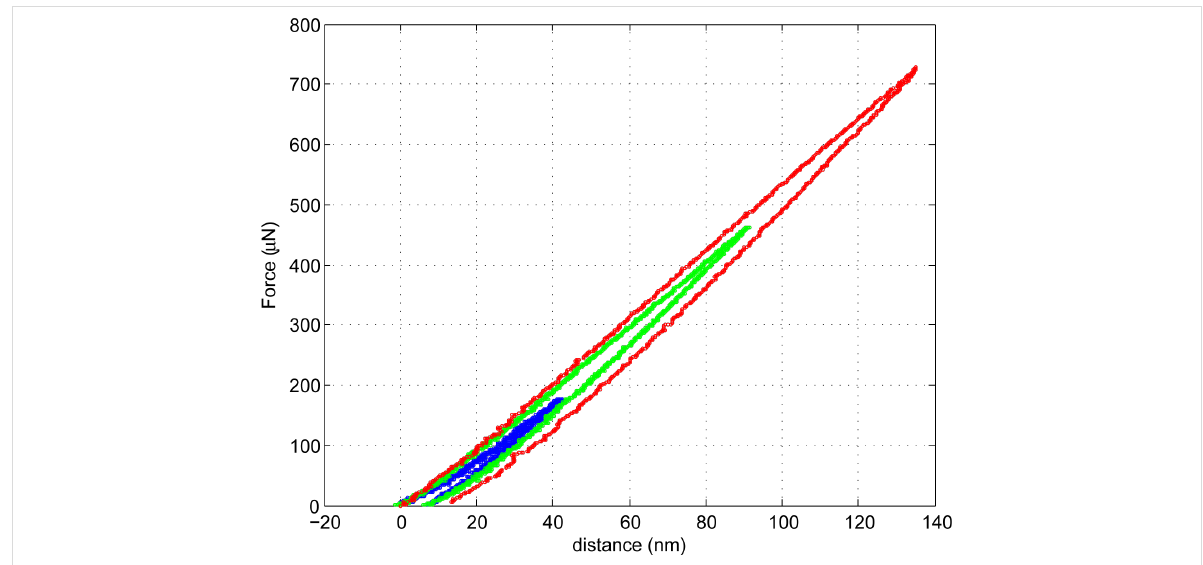
Figure 13: Force–distance curves on Corning Eagle Glass substrate.